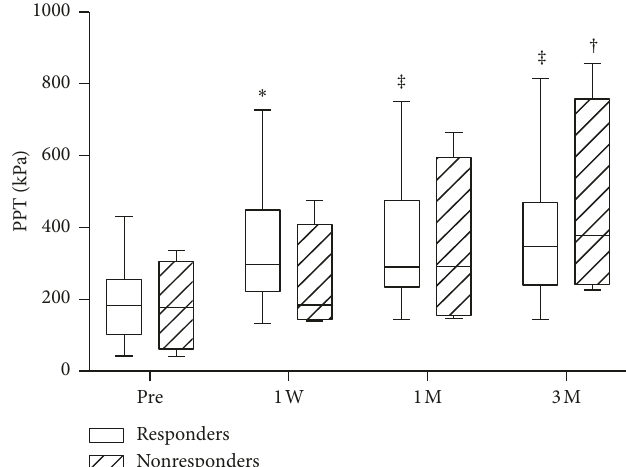
Figure 5: Pressure pain thresholds of responders and nonresponders at various time points. White and shaded bars indicate the PPT of responders ( n � 21) and nonresponders ( n � 4), respectively. ∗ p < 0 . 01 versus pretreatment PPT; † p < 0 . 001 versus pretreatment PPT; ‡ p < 0 . 0001 versus pretreatment PPT. PPT, pressure pain threshold; Pre, pretreatment; W, week; M,